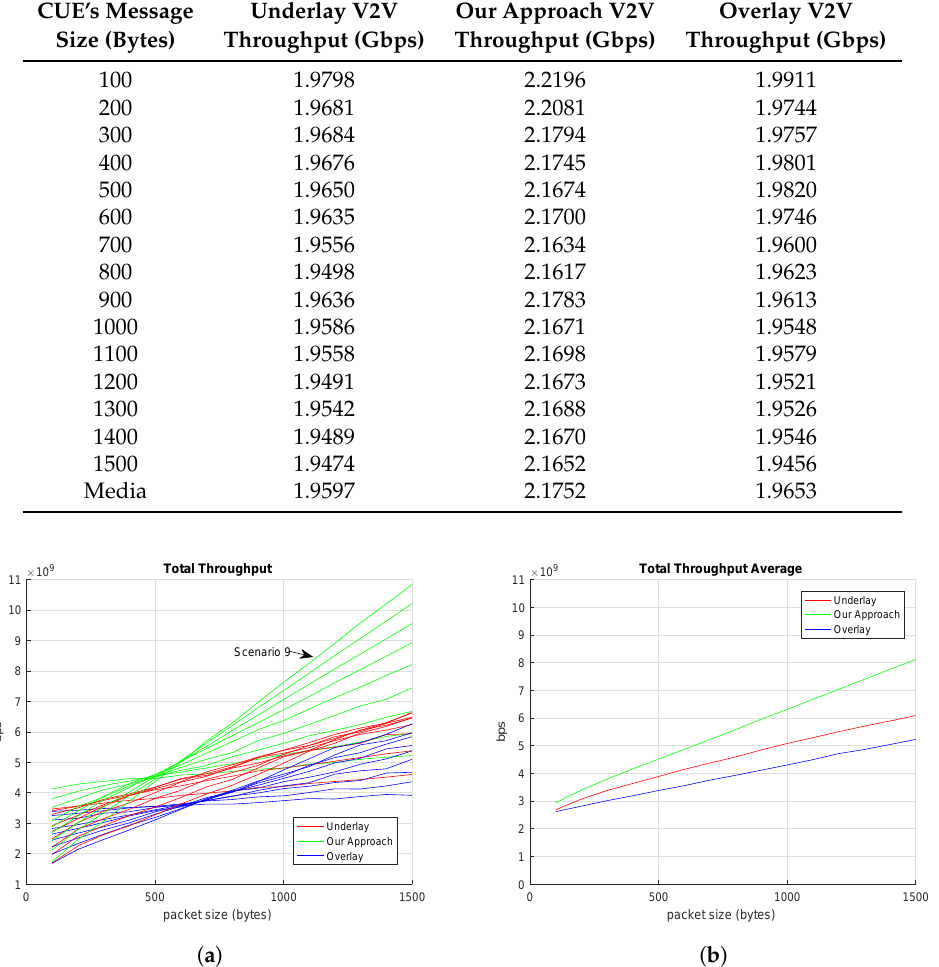
Figure 5. Throughput offered to V-UEs based on C-UEs’ traffic pattern. ( a ) Total Average Throughput in different scenarios; ( b ) Total Average Throughput for all set of